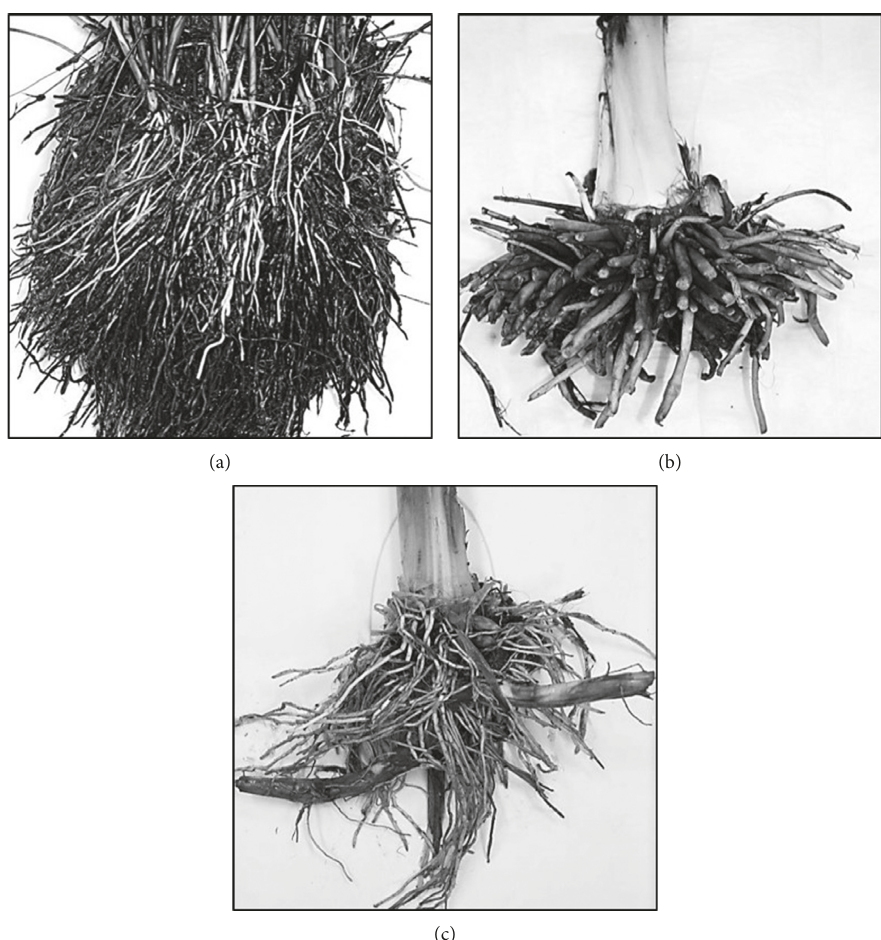
Figure 1: Photographs of root structure for (a) Juncus effusus , (b) Peltandra virginica, and (c) Typha latifolia